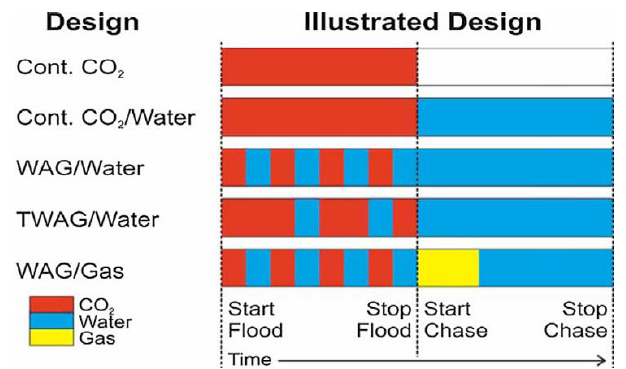
Figure 8. Schematic of various schemes of water-alternating-gas (WAG) injection [179].